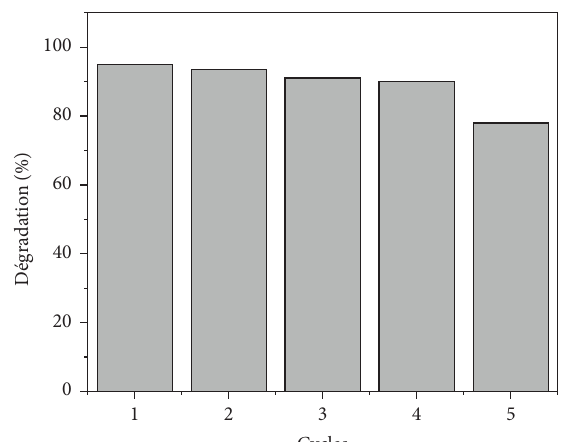
Figure 9: Reusability of heterogeneous Fenton composite. Reaction conditions: [MB] � 50mg/L, [H catalyst dosage � 2.5 g/L.